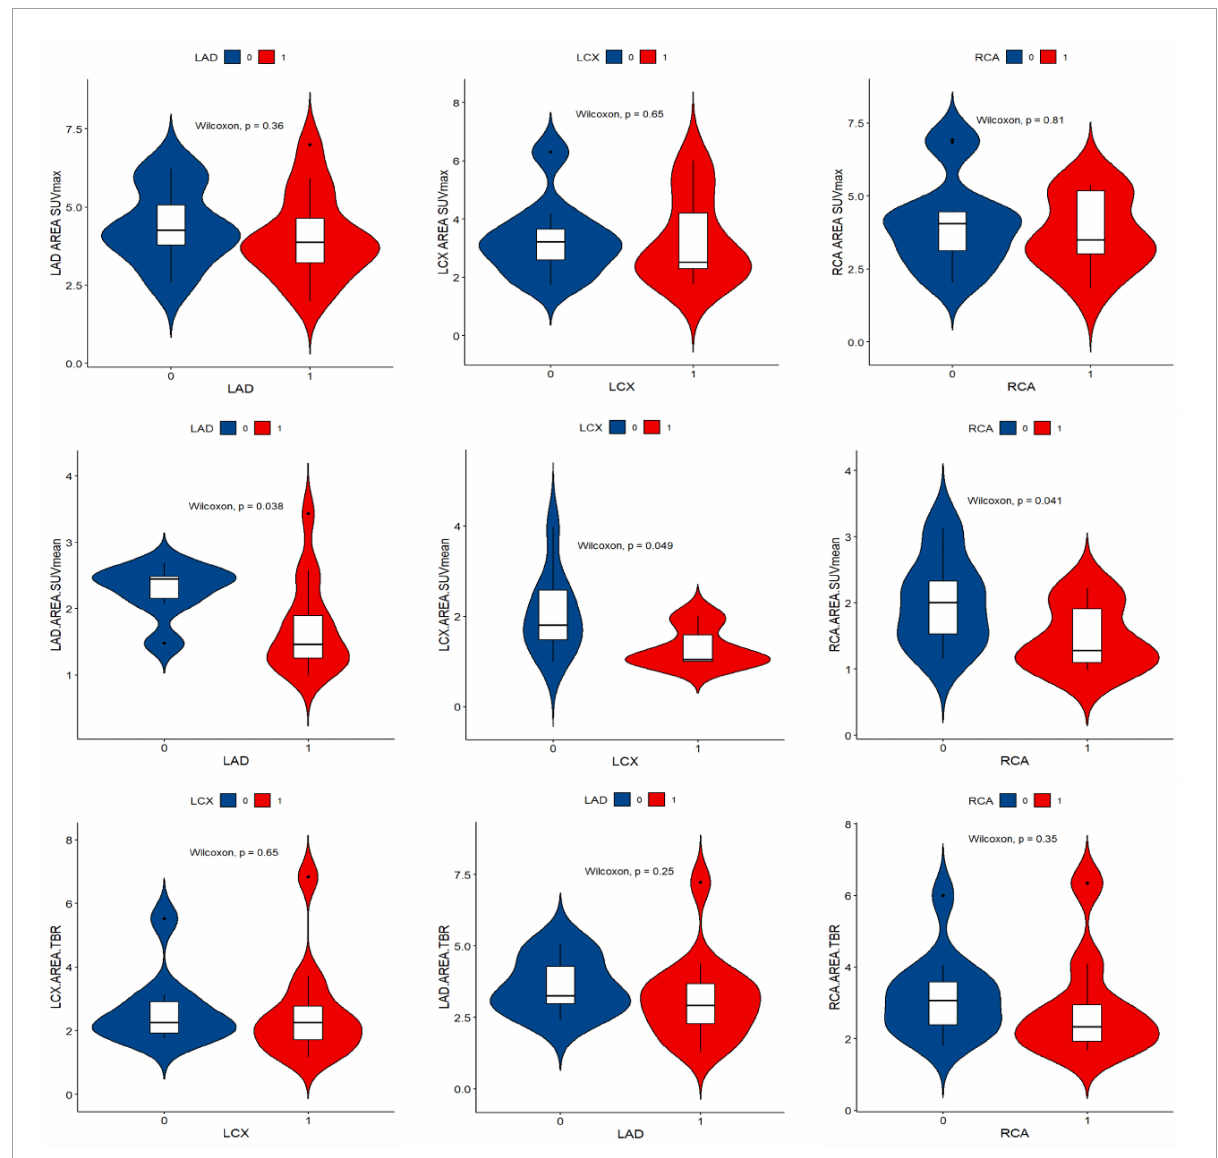
FIGURE5 Violin plot of univariate analysis of FAPI uptake difference in left ventricular calcification and non-calcification region. “1” stands for the calcific area, “0” stands for the non-calcific area. SUV mean demonstrated higher FAPI uptake in non-calcific areas than calcific